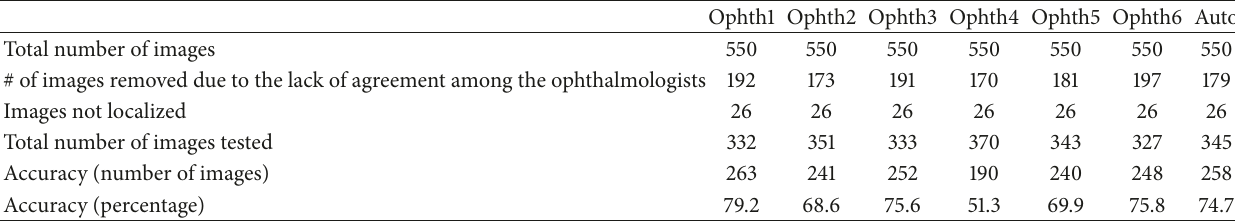
Table 10: The VCDR results for all the three images sets.